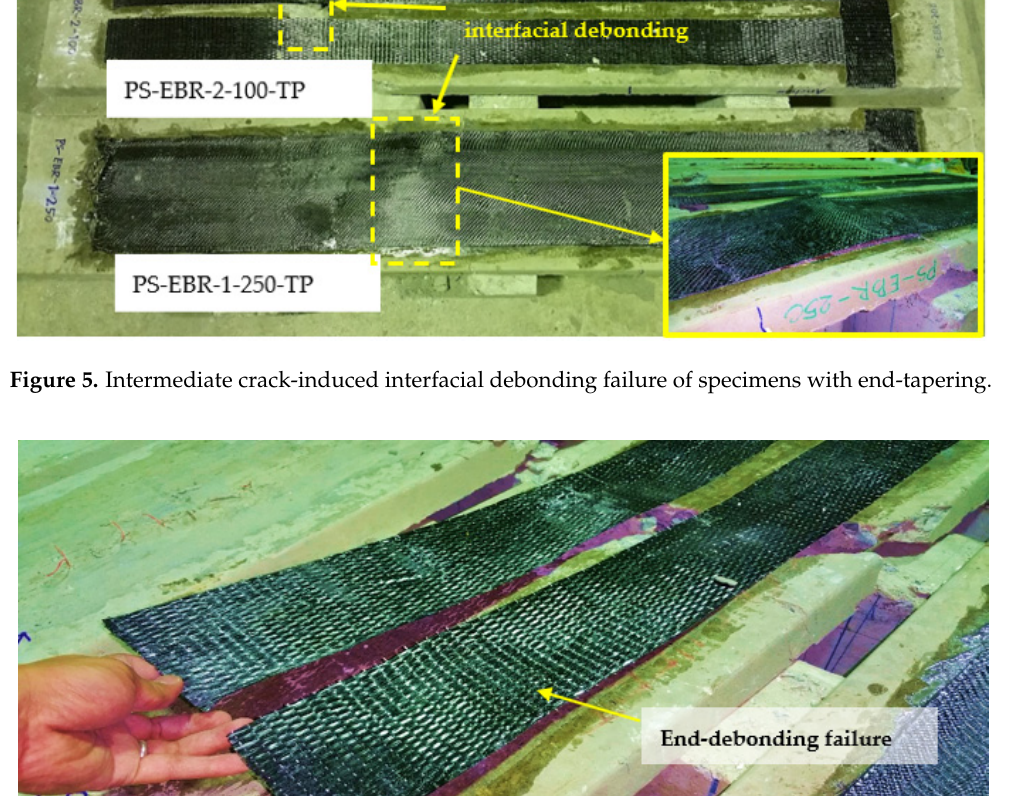
Figure 6. End-debonding failure of specimen without tapering (PS-EBR-2-100).